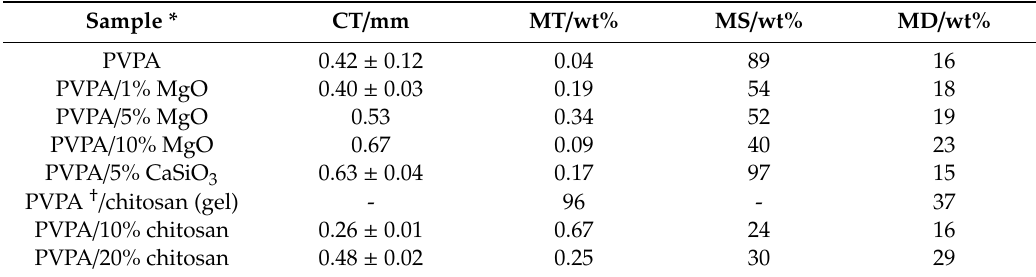
Table 1. Results of water-soak and water-solubility tests on coatings and discs.